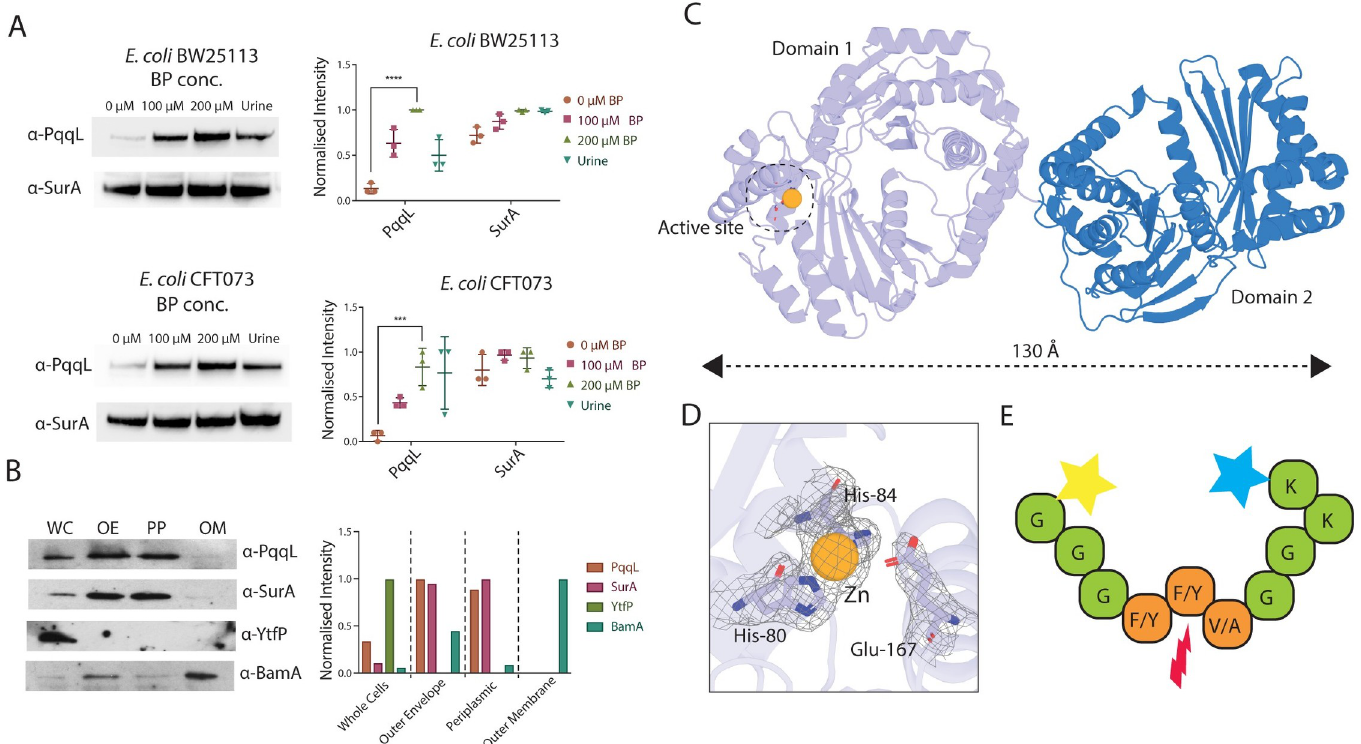
Fig 4. PqqL is an iron regulated, periplasmically localized, metallopeptidase, with an elongated conformation. A) An anti-PqqL western blot of E . coli BW25113 or CFT073 whole cells grown in the presence or absence of the iron chelator 2’2-bipyridine (BP) or in human urine. Detection of SurA is shown as a loading control. Left shows a representative blot, right shows normalised intensity of blots from 3 biological replicates. This shows more PqqL is produced under iron-limiting conditions. Indicated significant differences between conditions are based on student’s t-test ( � p � 0.05; �� p � 0.01; ��� p � 0.001; ���� p � 0.0001). B) A western blot of cell fractions from E . coli BW25113 grown under iron-limiting conditions (100 μ M BP), showing the distribution of PqqL in whole cell (WC), outer envelope (OE) and periplasmic (PP) fractions, but not associated with the outer membrane (OM). Controls using antisera recognizing SurA (periplasmic), BamA (outer membrane) or YtfP (cytoplasmic) are shown. Left shows a representative blot, right shows quantified intensity of this blot C) The crystal structure of PqqL showing that its two ‘clam shell’ domains adopt a highly elongated conformation in the crystal structure, engaging in minimal intra-molecular contacts. D) The crystal structure of PqqL illustrates the presence of a putative Zn ion in the protease active site of the enzyme. E) Peptidase screening assays shows that PqqL is an active peptidase with specificity for peptides containing a F/Y, F/Y, V/ A motif (Full data shown in S4 Table).